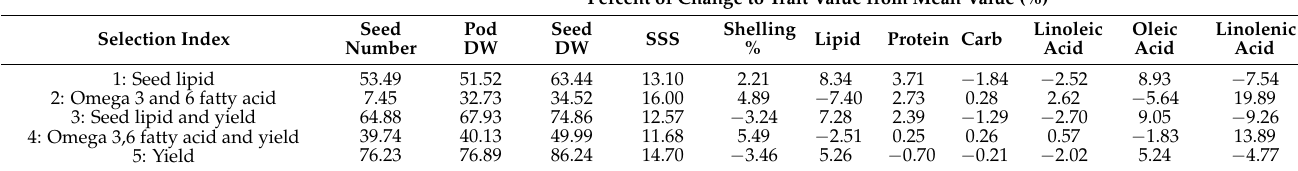
Table 8. Expected percent (%) change to value of each trait value using the five selection indices. Cal- culation was based on 15 bambara groundnut lines with the highest score for each index. Calculation of percent expected to change as outlined in Selection index and Scenario Testing (Section 2.5) Single seed size = SSS; Carb = carbohydrate; DW = dry weight. Percent of Change to Trait Value from Mean Value